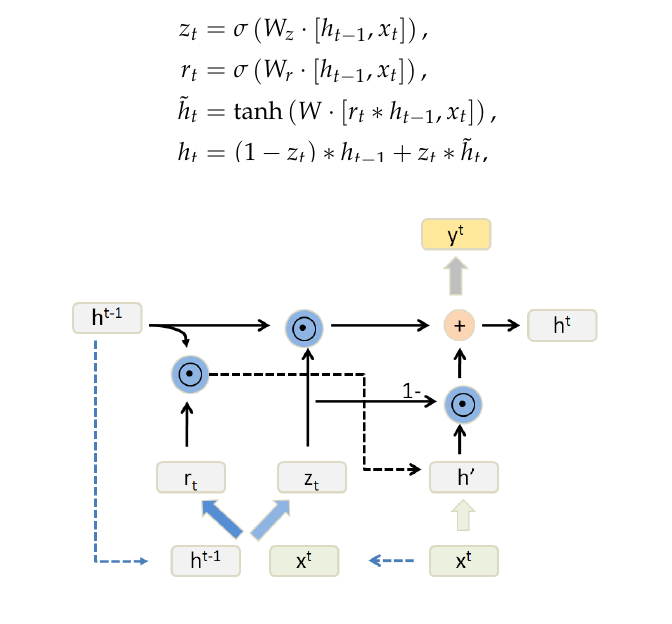
Figure 5. The architecture of the GRU(gate recurrent unit) block.